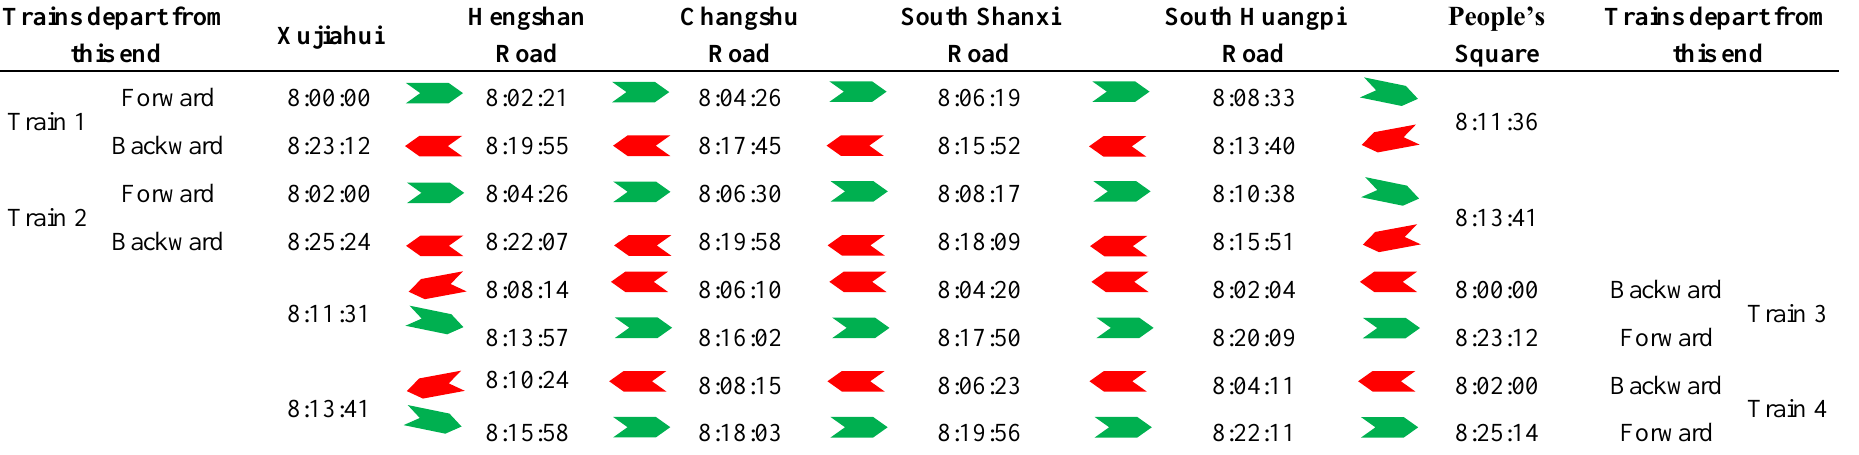
Table 4. The optimal departure time at each